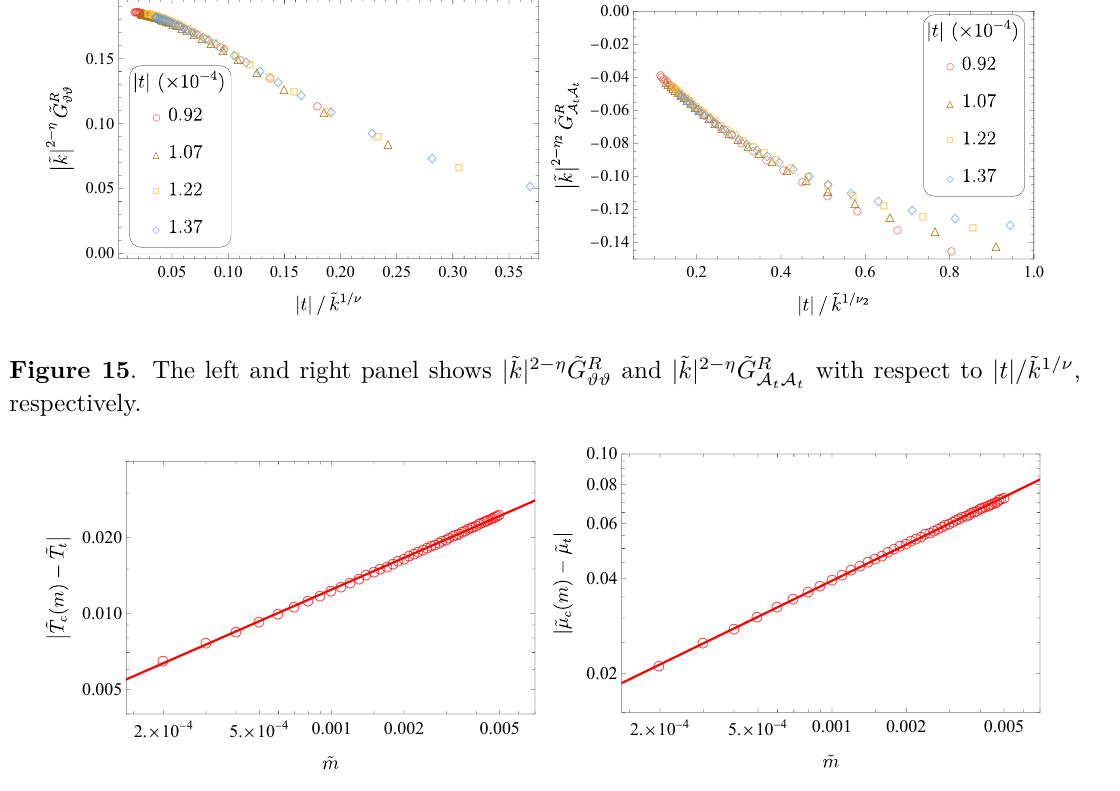
Figure 16 . The critical behaviors of | ˜ T c ( m ) − ˜ T t | (left panel) and | ˜ µ c ( m ) − ˜ µ t | (right panel) as a function of ˜ m near the